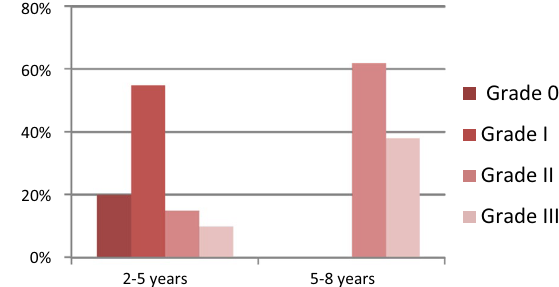
Fig. 2 Diagrammatic demonstration of the degree of cartilage degeneration and duration since ACL